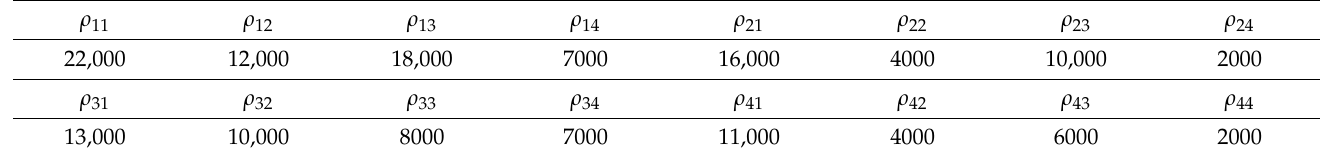
Table 3. The net profit statement of each unit and personnel